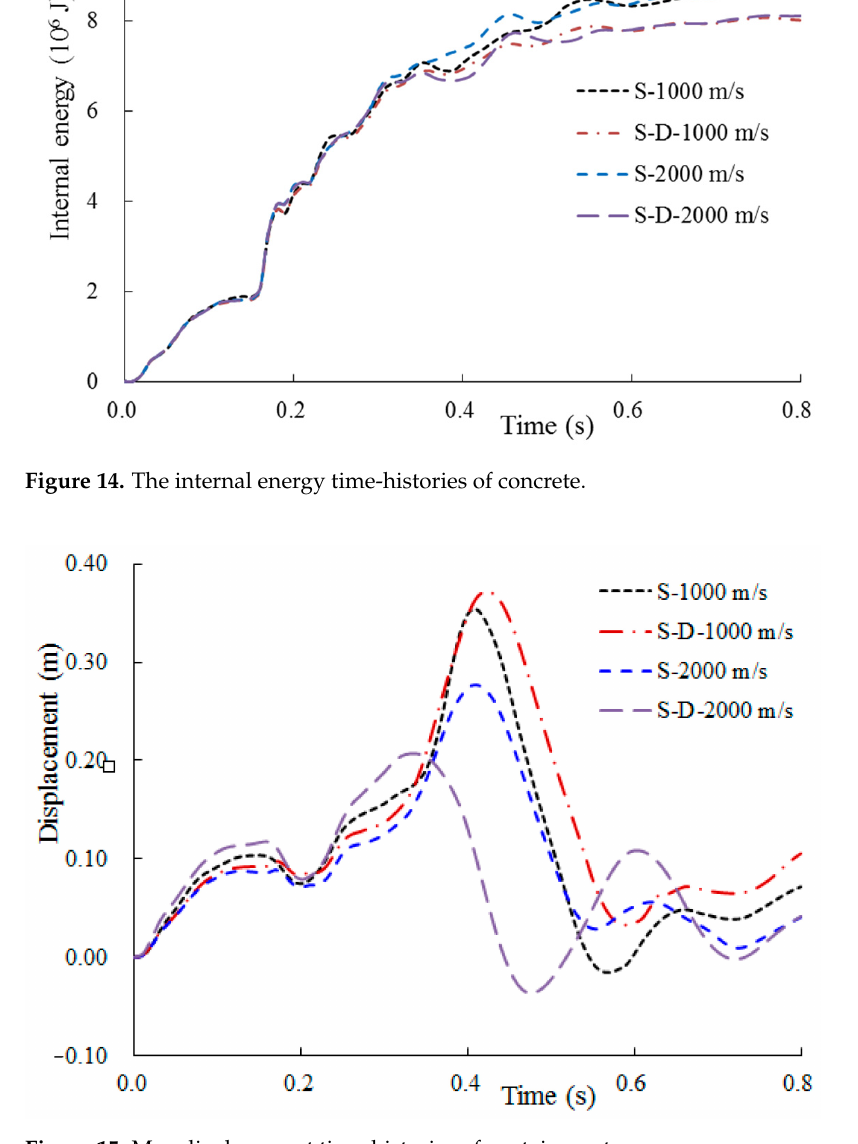
Figure 15. Max displacement time-histories of